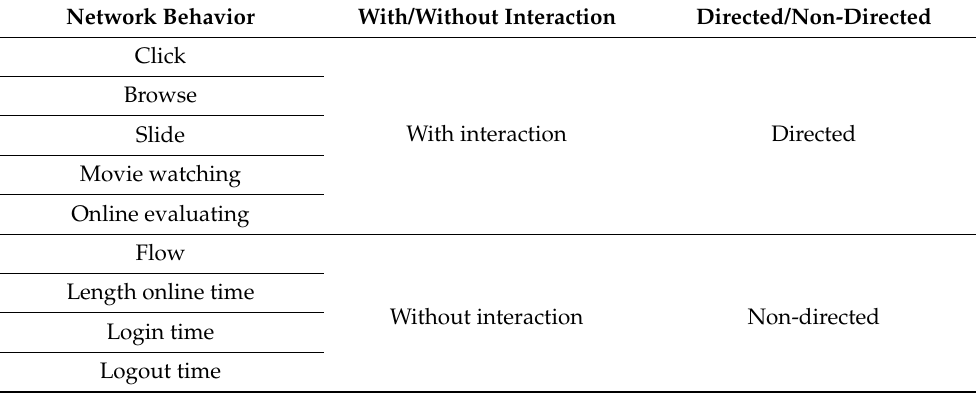
Table 1. The features of network